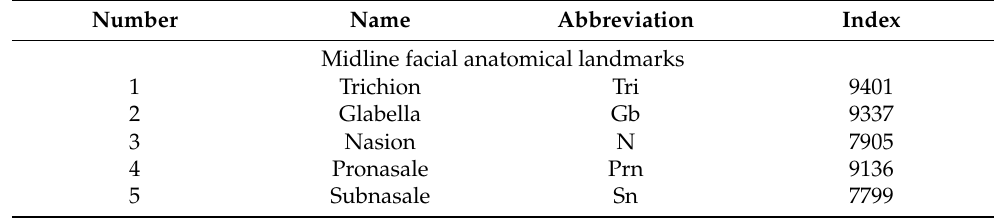
Table 1. Number, name, abbreviation, and index of facial anatomical landmarks used in this